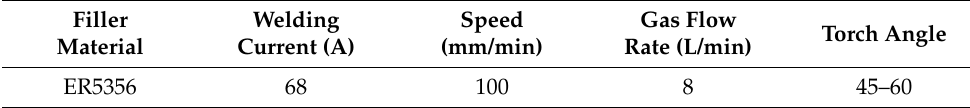
Table 2. Optimum parameters for GTAW of